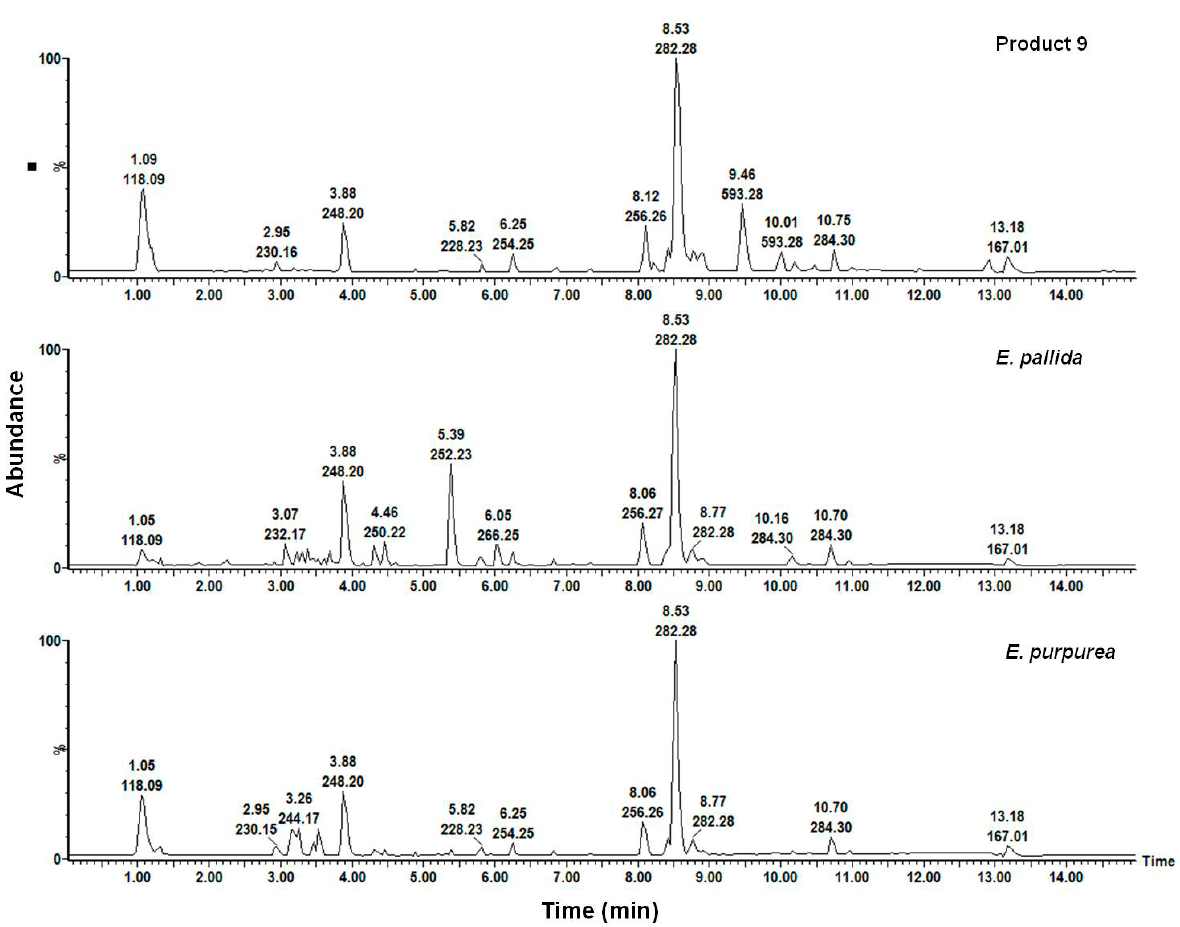
Figure 12. A comparison of the methanol root extracts of product 9 and two Echinacea